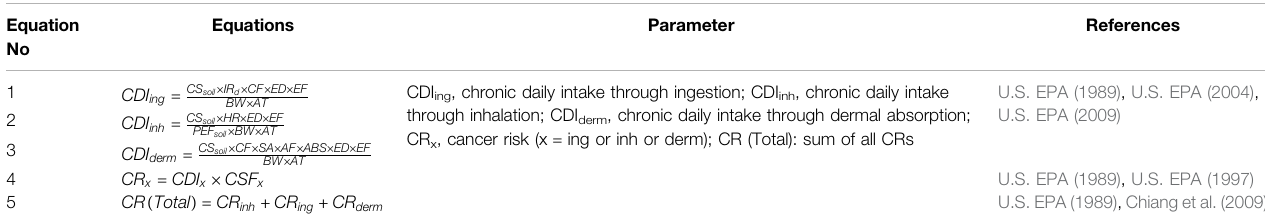
TABLE 3 | Equations to calculate exposures and CR